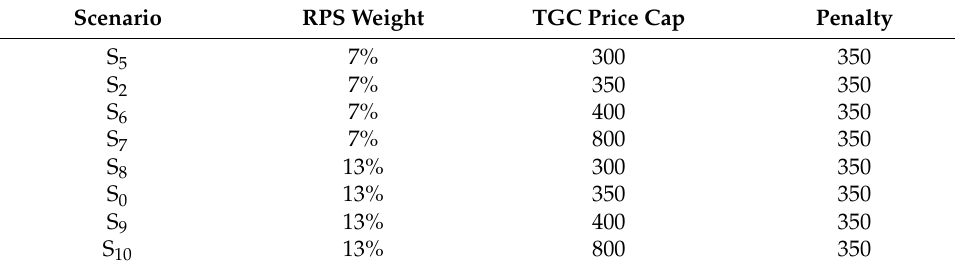
Table 3. Scenarios for analyzing the impacts of TGC price